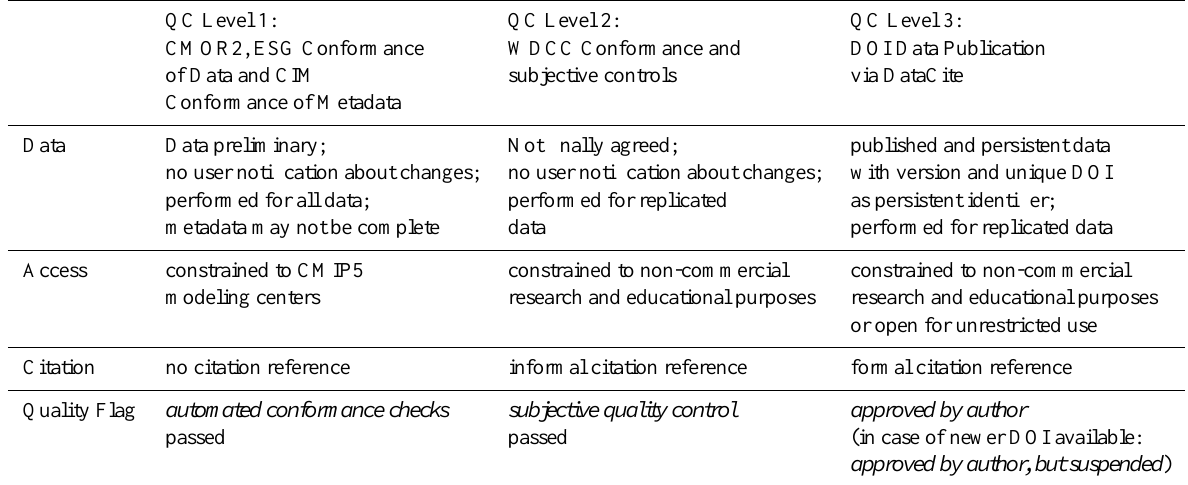
Table 1. CMIP5/IPCC-AR5 quality control levels and their implications.